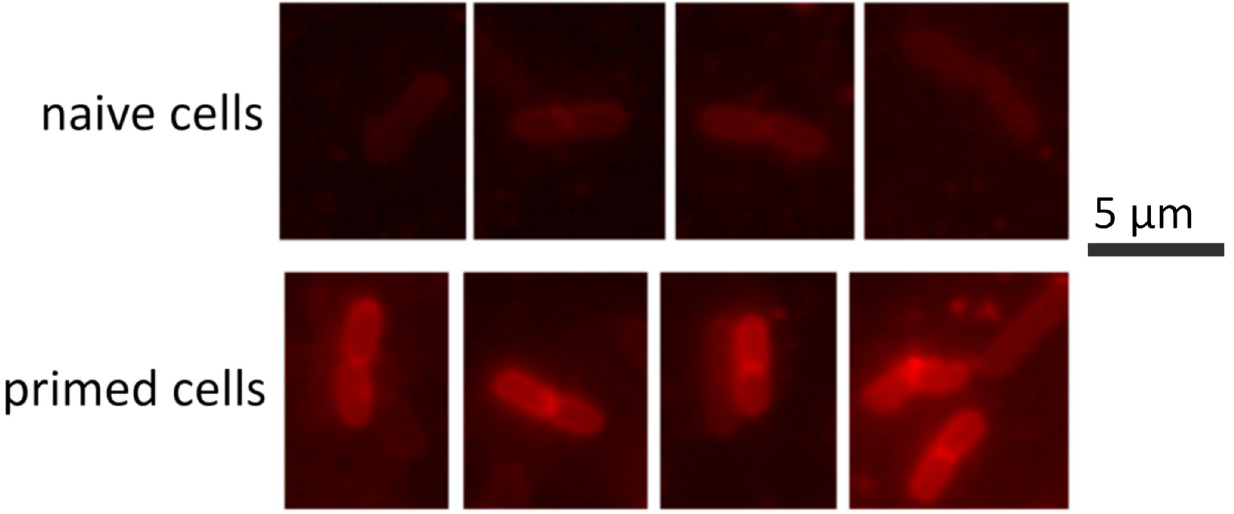
Fig 7. Detection of curli production by primed cells after exposure to a killing dose (10xMIC) of melittin for 30 minutes before image acquisition. Curli production is only detected in a small proportion of primed cells (survival fraction). After treatment, we exposed the cells to ECtracer 680 (Ebba Biotech, Sweden), a red fluorescent tracer molecule for staining of